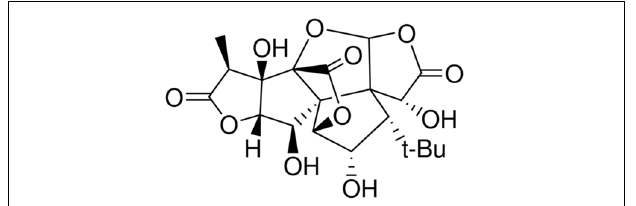
FIGURE 1 | Chemical structure of